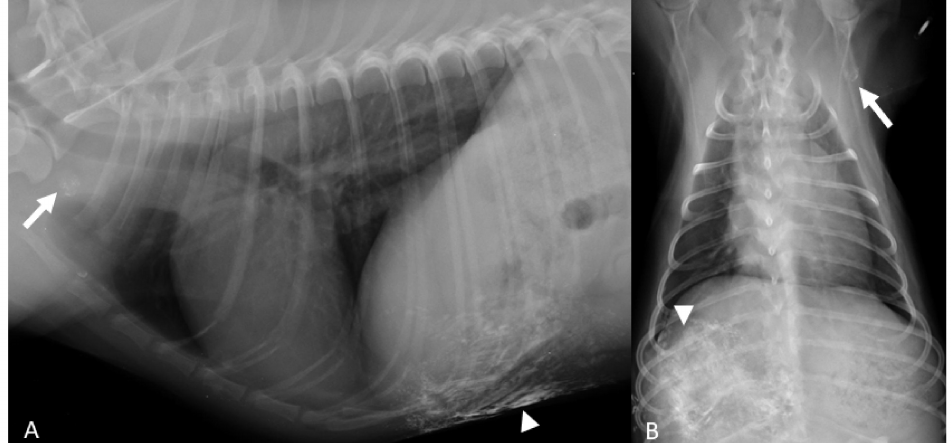
Figure 1. ( A , B ) Doberman Pinscher 4 yr (Case #9). Right lateral and ventro-dorsal radiographic projections of the thorax show the lipiodol surrounding the neoplastic mammary gland (arrowheads) and the contrast enhanced contra-lateral axillary lymph node (arrows).